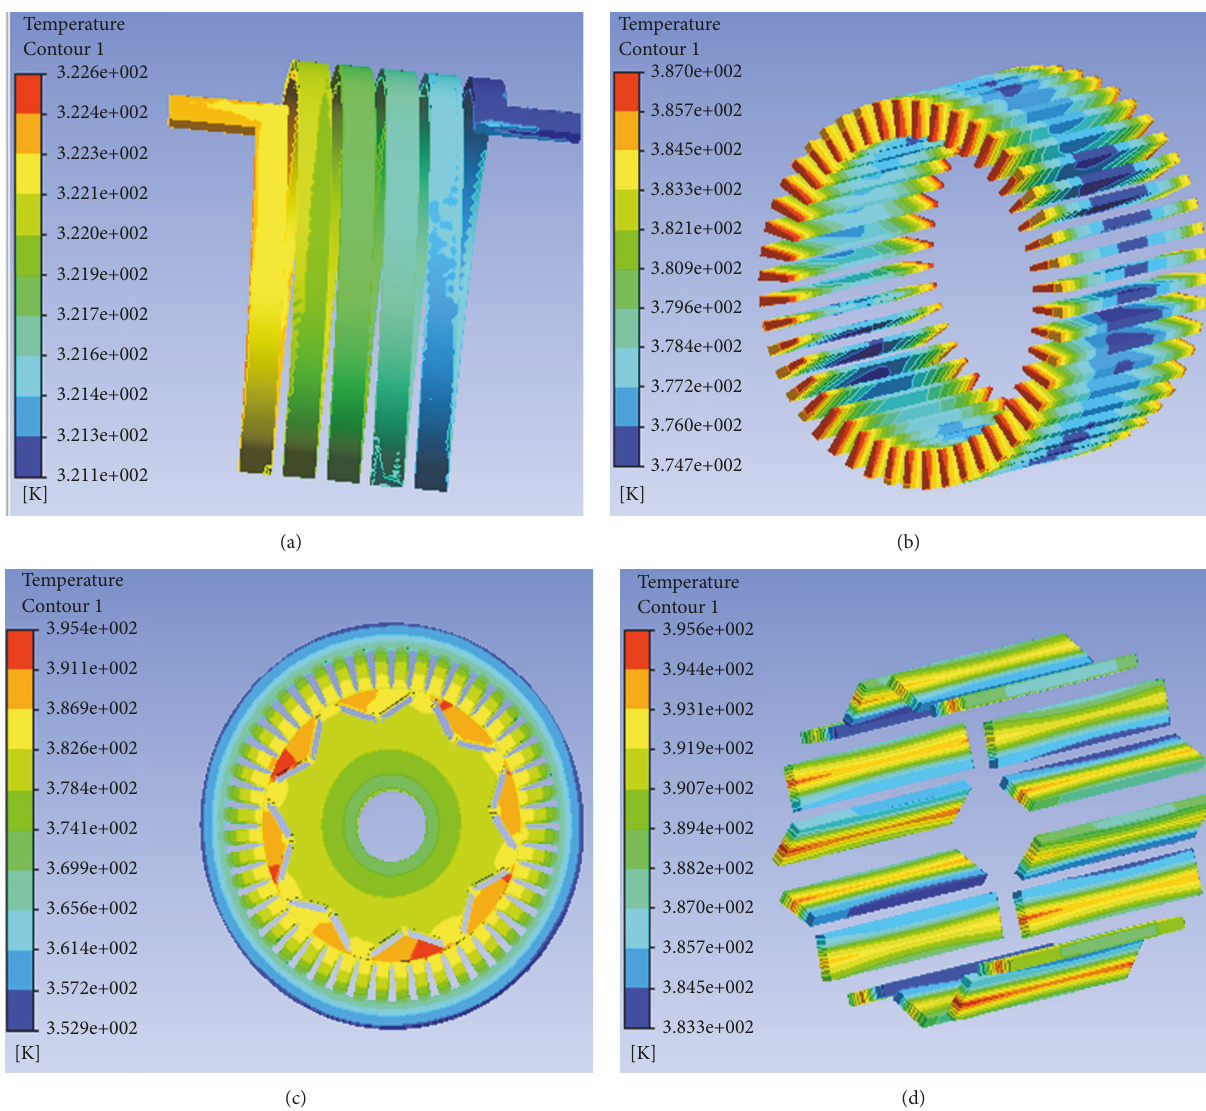
Figure 6: Temperature distribution after considering the harmonic loss: (a) water jacket; (b) stator winding; (c) stator and rotor core; (d)